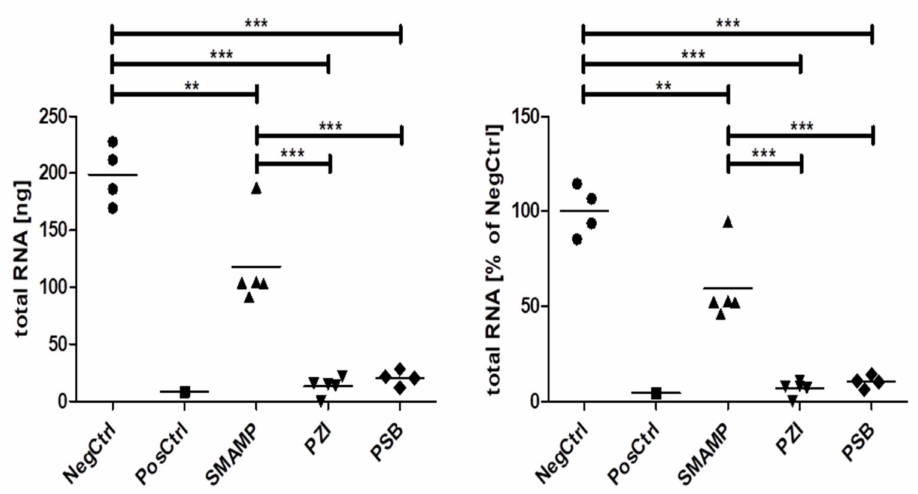
Figure 2. Total extractable RNA in the harvested biofilms as a percentage of the mean of the negative control ( NegCtrl = uncoated silicon wafer, PosCtrl = uncoated silicon wafer with additional CHX). Stars depict significant differ- ences as determined by one-way ANOVA with Tukey’s post-hoc test. ** p < 0.01, *** p <